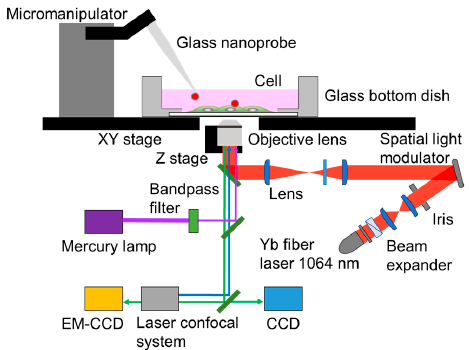
Figure 2. A schematic diagram of the experimental system. CCD: Charge-coupled device; EM-CCD: Electron multiplying-CCD.